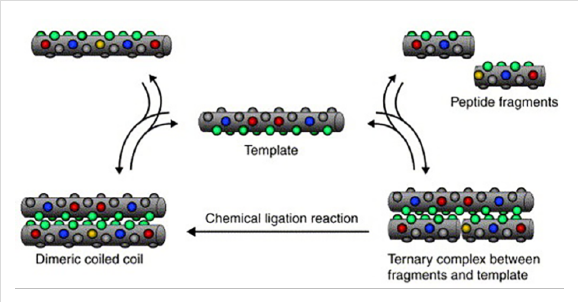
Figure 7: Self-replication of a helical peptide. Molecular recognition leads to the formation of a stable coiled coil structure from smaller peptide fragments. Depending on the length and stability of the coiled coil structure, the template-duplex dissociates in the original template and a copy